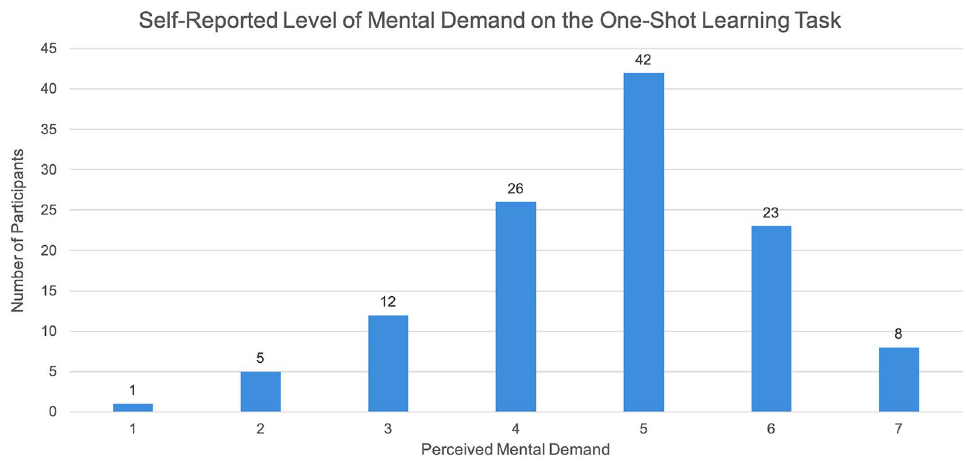
Figure 5. Self-reported level of mental demand required for completing our one-shot learning task (1=Low, 7=High). The distribution of responses indicate that the task was sufficiently difficult to engage participants, but not so difficult that we should be concerned about confounds to human